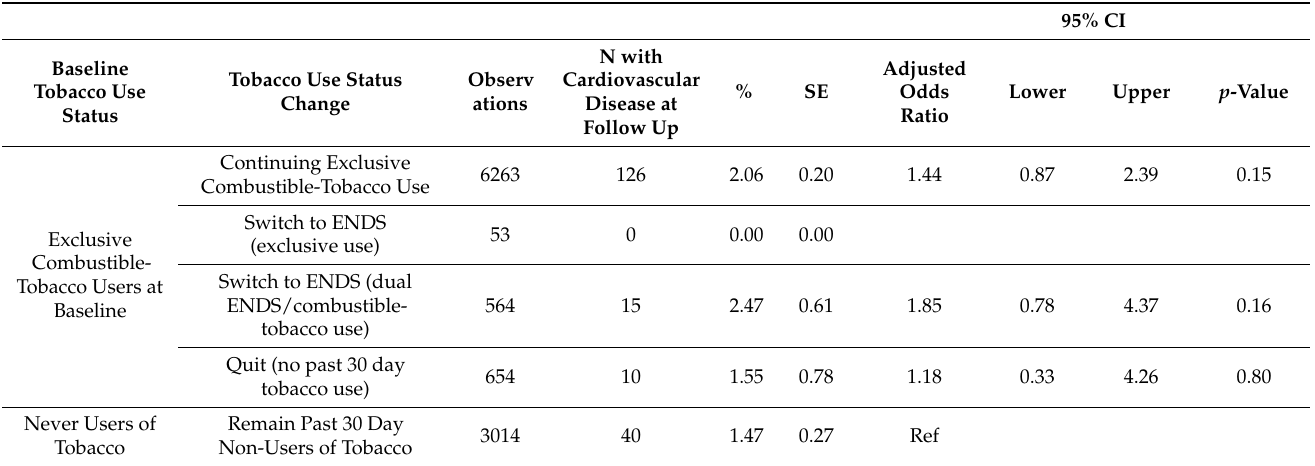
Table 2. Cardiovascular disease at follow up by baseline and interim tobacco use status: adjusted GEE results among 9828 observations.